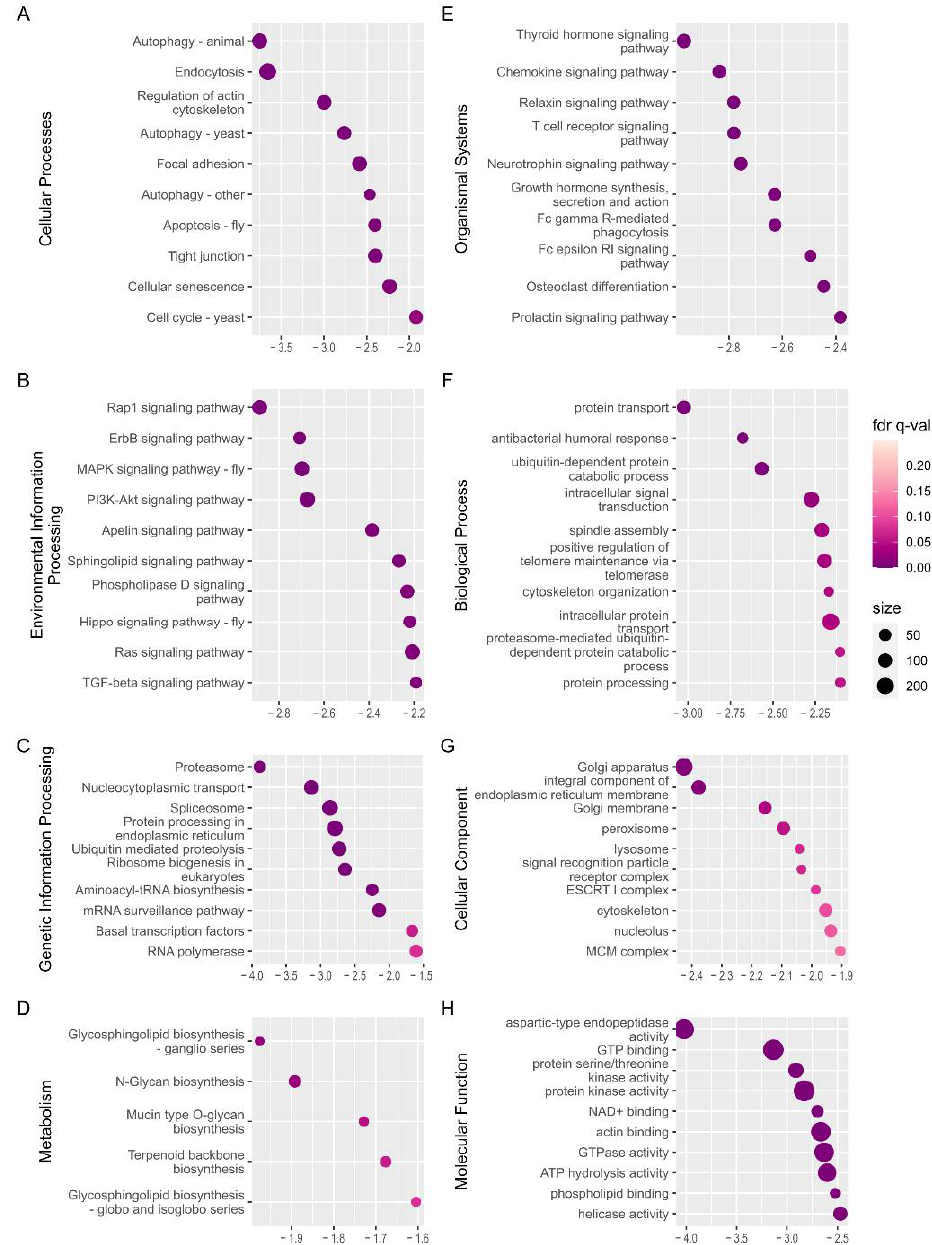
Figure 5. Gene set enrichment analysis (GSEA) of WSG1 versus WSG2. ( A – E ) Significantly negatively enriched gene sets of the top categories of KEGG orthology pathways; the y -axis shows the definition from the gene set of the KEGG pathway. ( F – H ) Significantly enriched gene sets of GO annotation of major categories; the y -axis shows the GO terms of the enriched gene set. The normalised enrichment score (NES) is indicated on the x -axis in ( A – H ). A negative sign in NES demonstrates that gene sets were activated in state of WSG1. The circle size represents the number of genes in each enriched gene set.